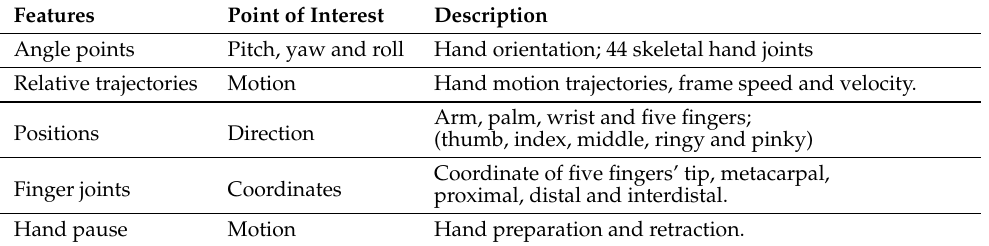
Table 3. Extracted